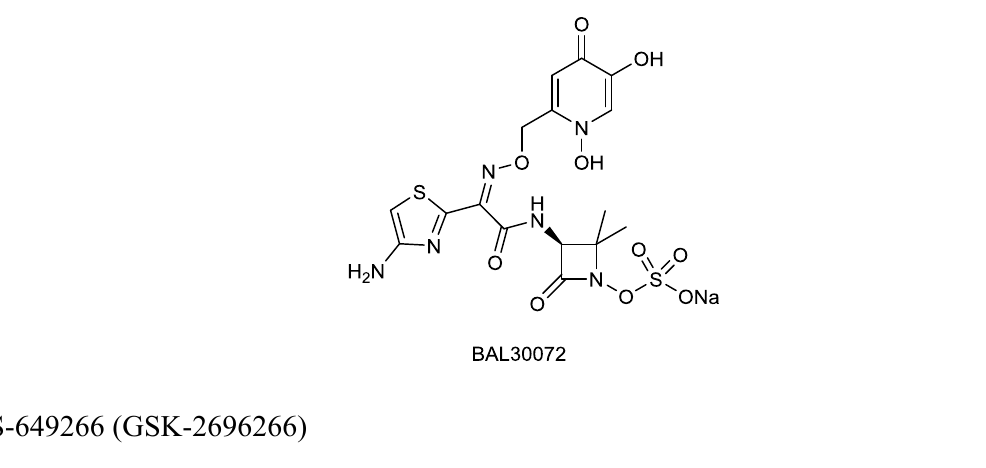
Figure 7. Chemical structures of BAL30072.